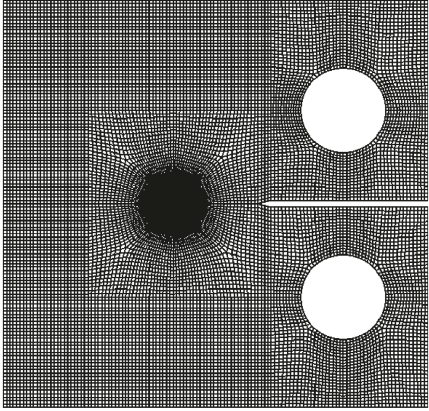
Figure 9: CT sample finite element model.